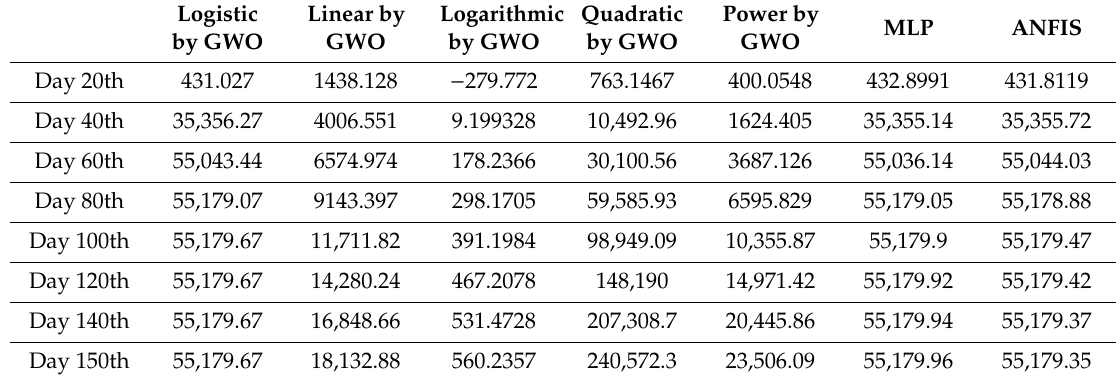
Table 20. The outbreak prediction for Germany through 150 days.